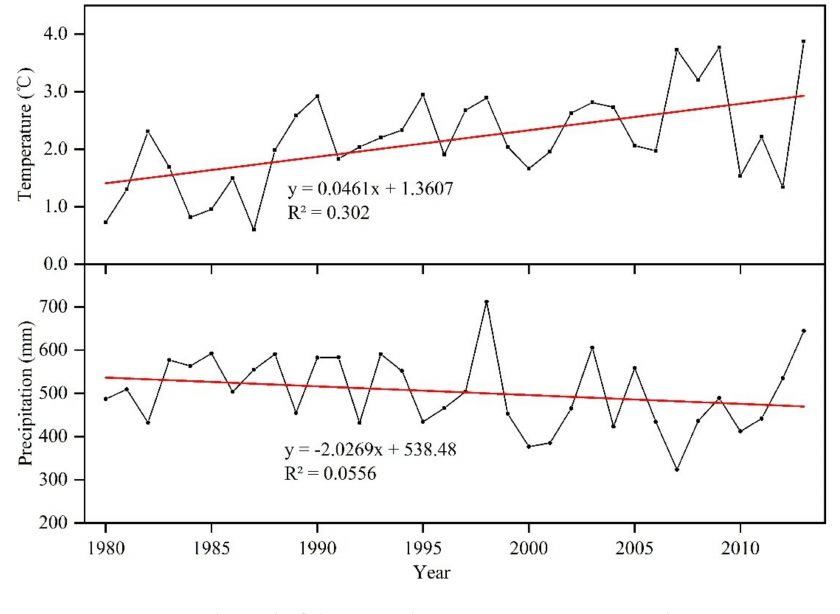
Figure 4. Temporal trend of the annual average temperature and precipitation.